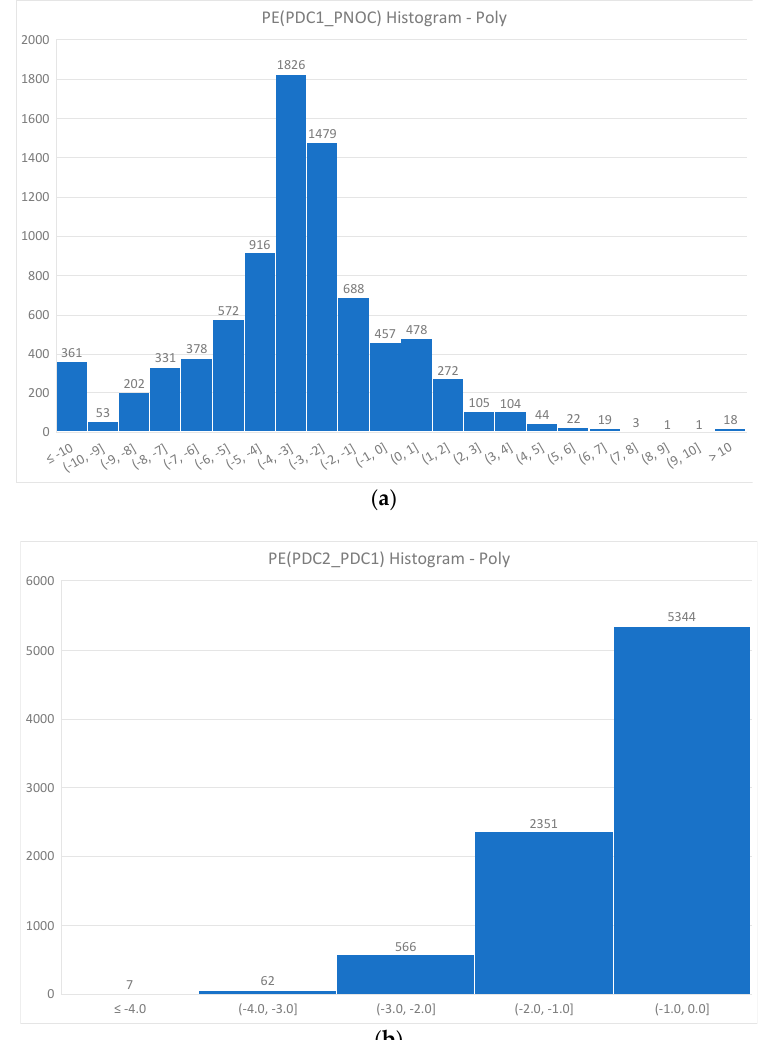
Figure 5. Histograms of the Percentage Error 𝑃𝐸 (cid:2869)(cid:3015)(cid:3016)(cid:3004) concerning 𝑃𝐷𝐶 (cid:2869)(cid:3015)(cid:3016)(cid:3004) and 𝑃 (cid:3015)(cid:3016)(cid:3004) ( a ), and the Percentage Error 𝑃𝐸 (cid:2870)(cid:3015)(cid:3016)(cid:3004) concerning 𝑃𝐷𝐶 (cid:2870)(cid:3015)(cid:3016)(cid:3004) and 𝑃𝐷𝐶 (cid:2869)(cid:3015)(cid:3016)(cid:3004) ( b ); polycrystalline modules.